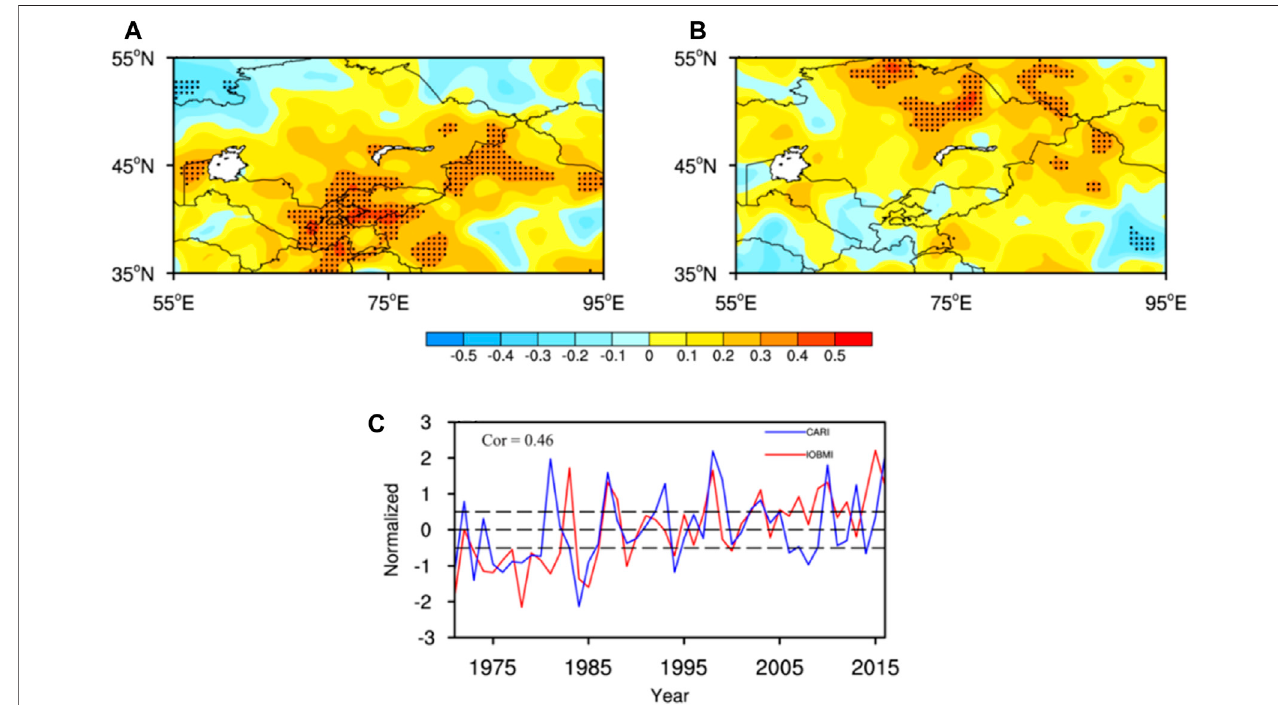
FIGURE 3| Correlation of (A) IOBMI and (B) IODI with summer rainfallover CA; dotted regions show signi fi cance at α (cid:2) 0 . 05level. (C) Time series ofthe CARI and IOBMI during 1971 – 2016.